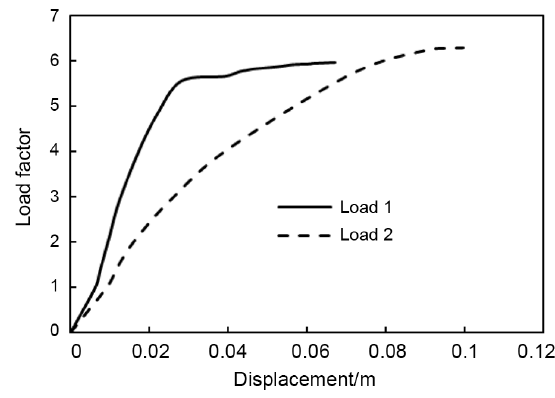
Fig. 5. Load factor vs. displacement for different